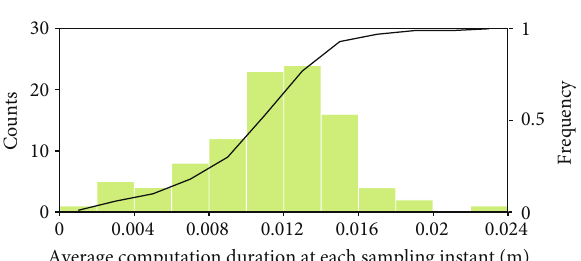
Figure 36: Statistical distribution and cumulative frequency of the average computation